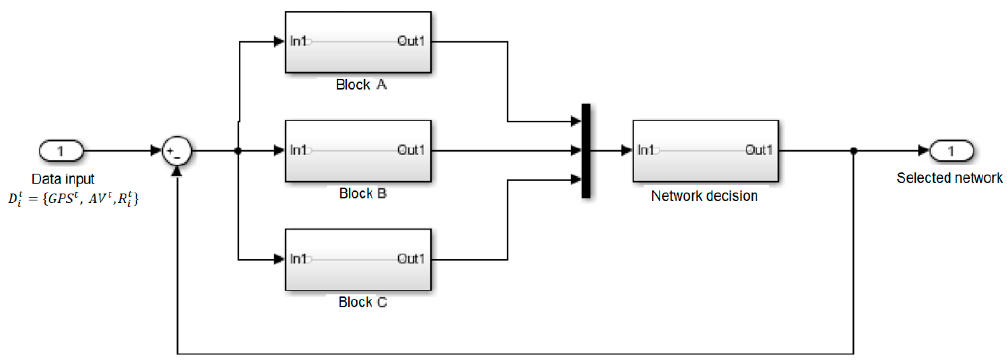
Figure 3. Proactive cross-layer framework block diagram.